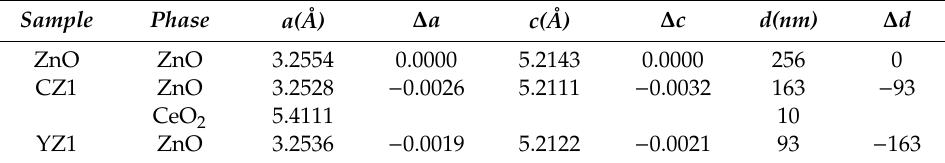
Table 1. Average crystalline size (d (nm)), lattice parameters (a (Å) and c (Å)) and their difference due to the addition of lanthanide ions respect that of pure zinc oxide ( Δ d ), Δ a and Δ c are respectively the difference between the value of a and c lattice parameter of the pure oxide(ZnO) respect to the mixed system (CZ1, YZ1).